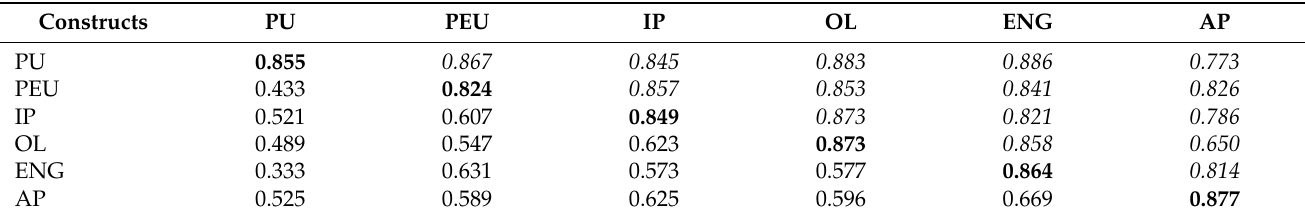
Table 3. Discriminant validity.